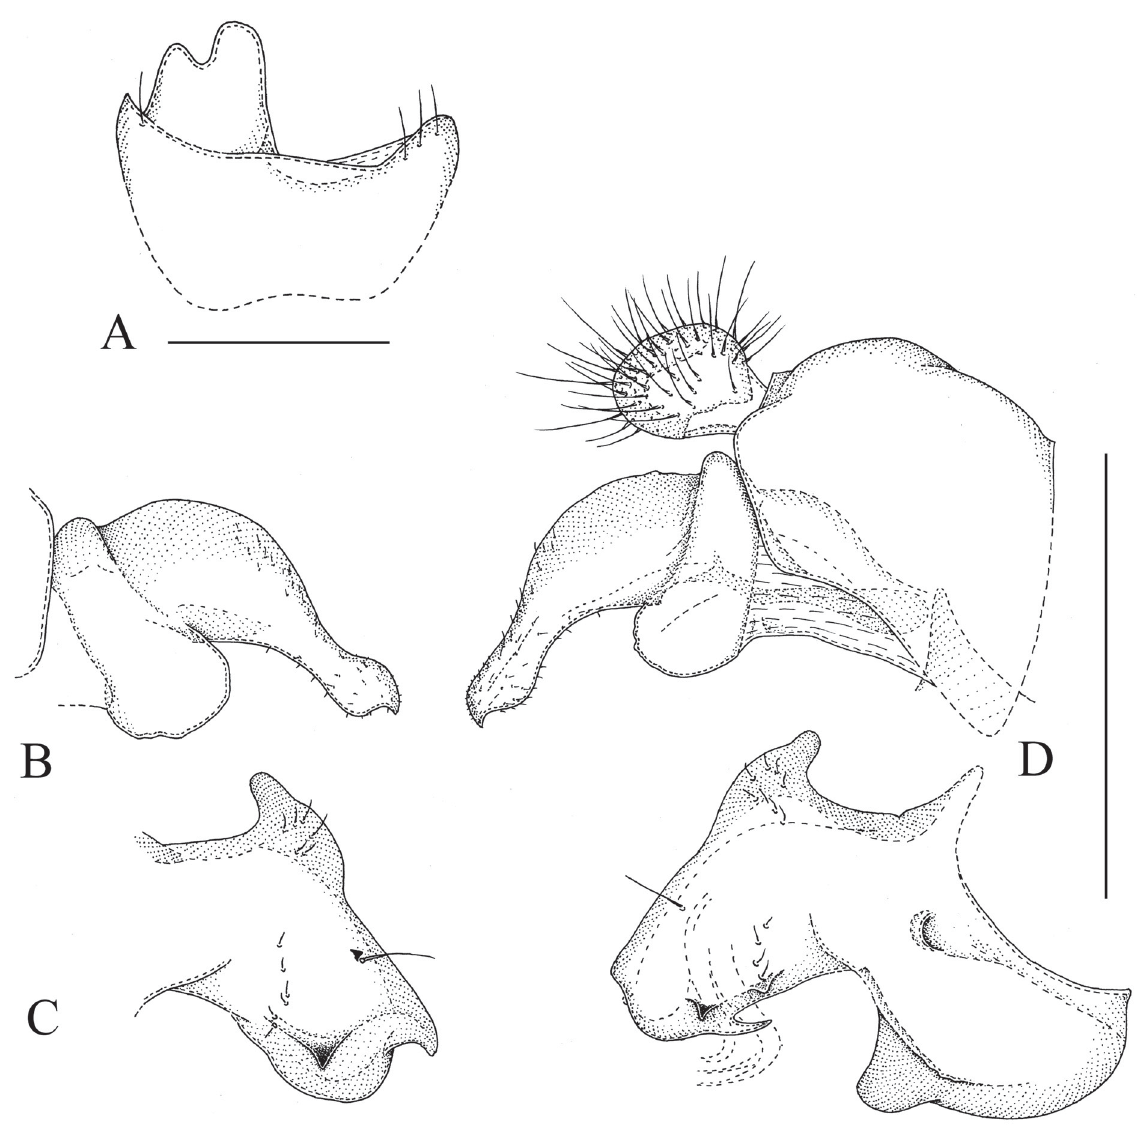
Fig. 14. Sphegina (Asiosphegina) bi fi da sp. nov., holotype, ♂ . A . Sternum IV, ventral view. B . Left surstylus, lateral view. C . Left superior lobe, lateral view. D . Genitalia, right side, lateral view. Scale bars = 0.5